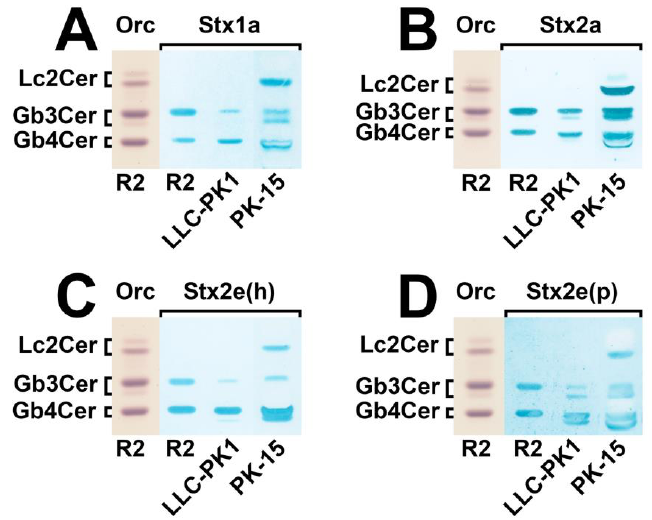
Figure 2. Detection of Stx-binding GSLs in the neutral GSL preparations of porcine LLC-PK1 and PK-15 renal epithelial cell lines. ( A – D ) Stx1a and Stx2a subtypes originated from human EHEC isolates.